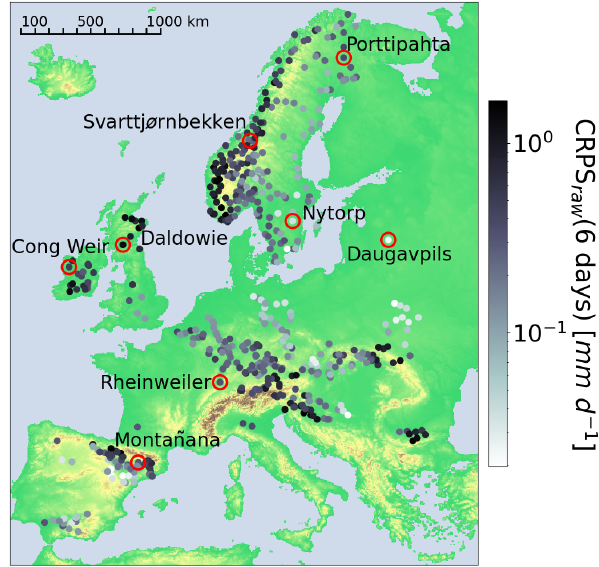
Figure 3. Map showing the locations of the 522 stations evaluated. The marker colour shows the continuous ranked probability score (see Sect. 4.3.4) for the raw forecast at a lead time of 6d on a log scale. Perfect score: CRPS = 0. Stations used as examples in Sect. 5 are labelled and highlighted by the red